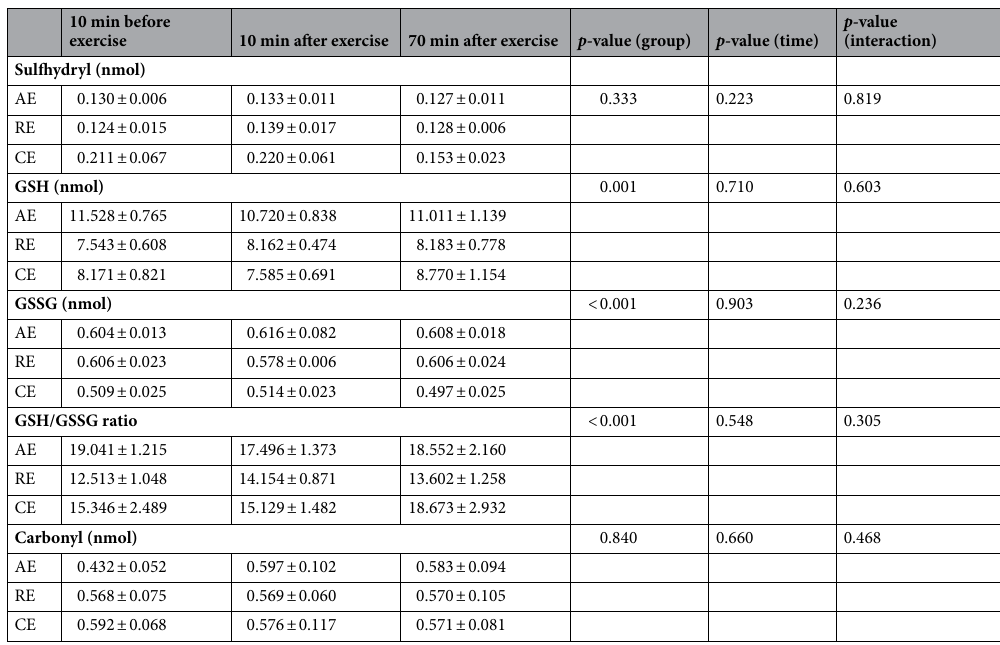
Table 3. Comparison of oxidative stress parameters in patients with hypertension undergoing three different exercise interventions. Data described as mean ± standard error. AE: aerobic exercise session (n = 11); RE: resistance exercise session (n = 11); CE: combined exercise session (n = 11). GSH, reduced glutathione; GSSG, oxidized glutathione; GSH/GSSG, ratio between reduced and oxidized glutathione. GEE with Bonferroni post- hoc test was used ( p <